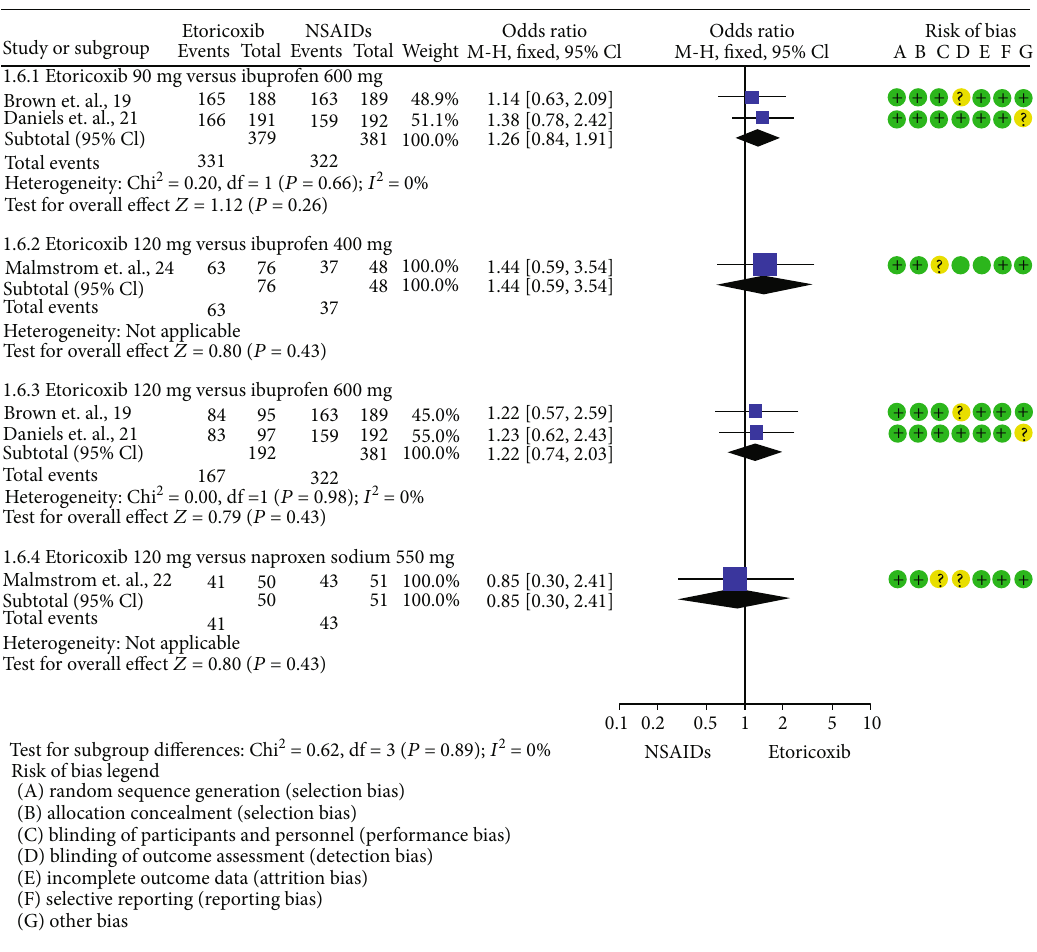
Figure 6: Meta-analysis according to the etoricoxib dose and patient